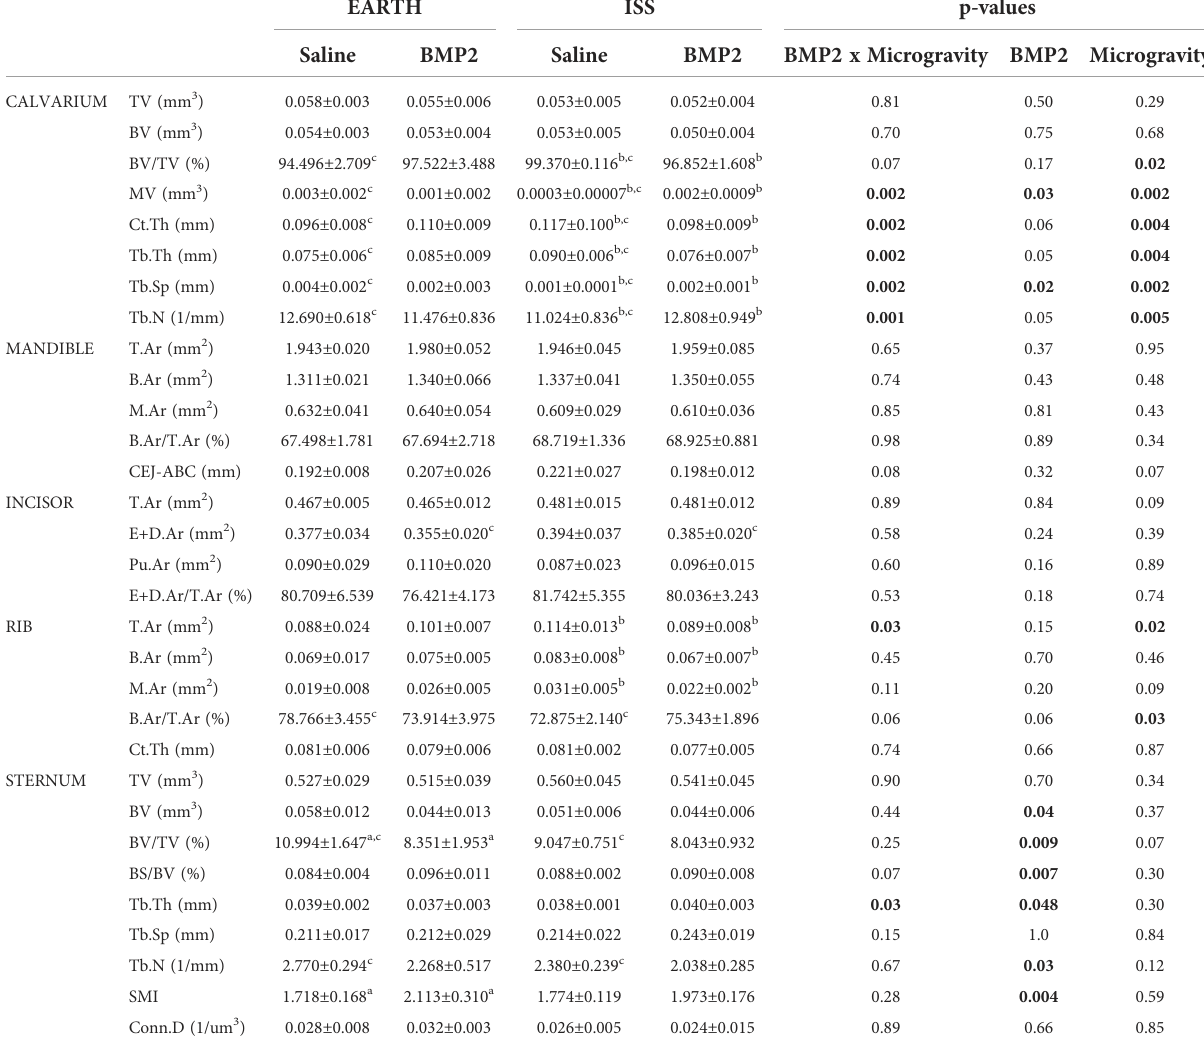
TABLE 1 m CT assessment of bone microarchitecture in non weight-bearing bones: calvarium, mandible, incisor, rib, and sternum, from mice housed both on Earth and at the International Space Station (ISS). EARTH